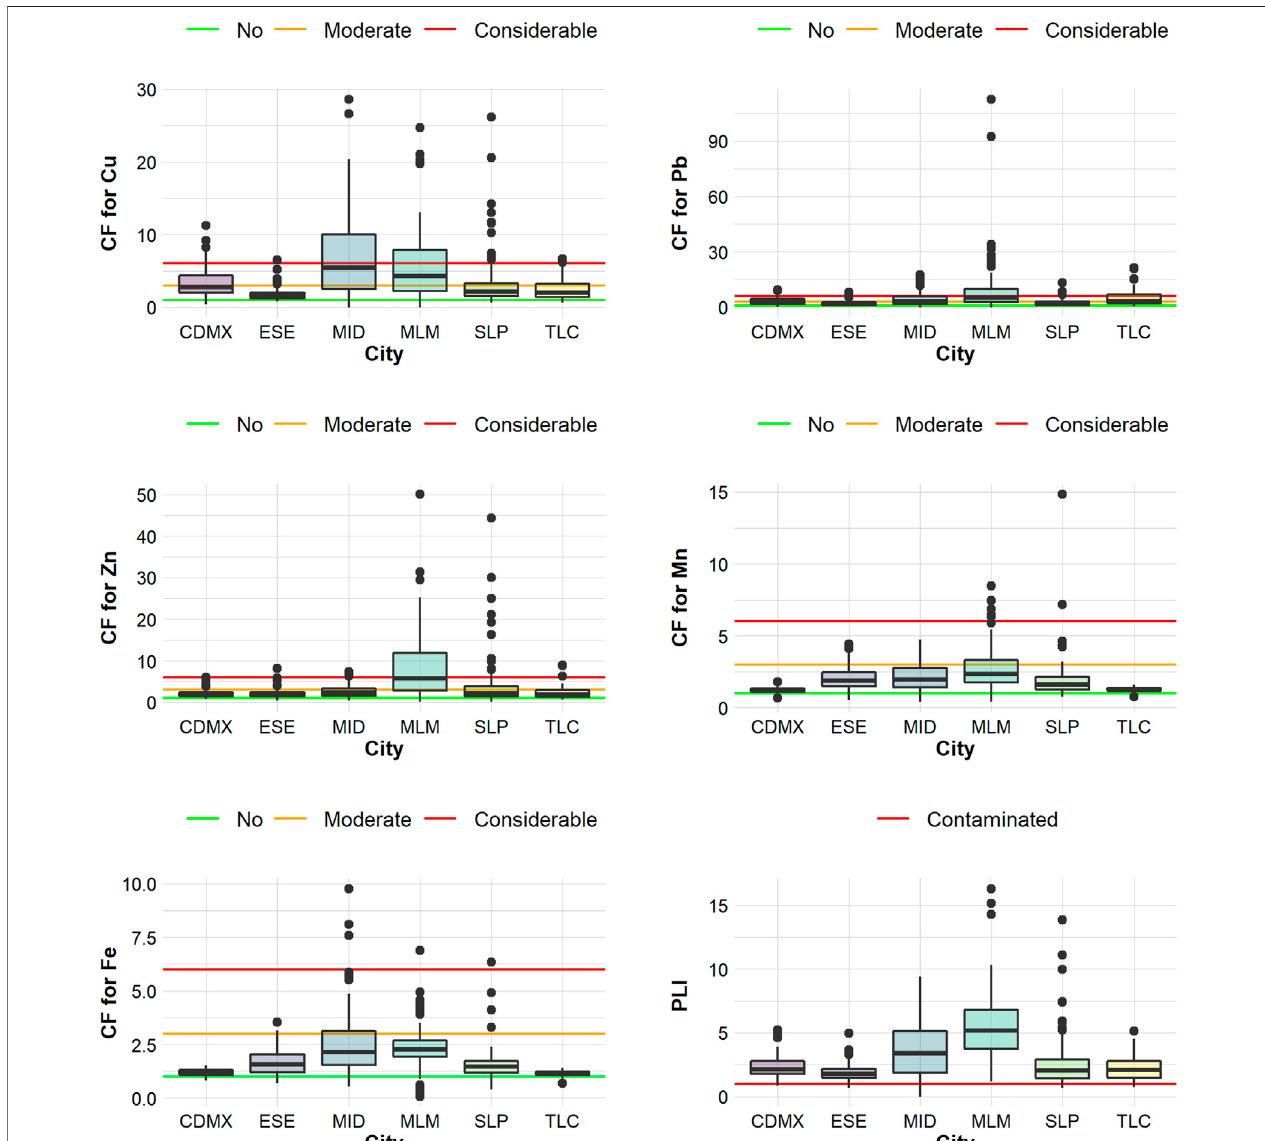
FIGURE 2 | Box plots of the contamination factors (CF), using decile 1 of each city as the background value. CDMX: Ciudad de México, ESE: Ensenada, MID: Mérida, MLM: Morelia, SLP: San Luis Potosí, TCL: Toluca. PLI: pollution load index. Horizontal lines represent the contamination levels.